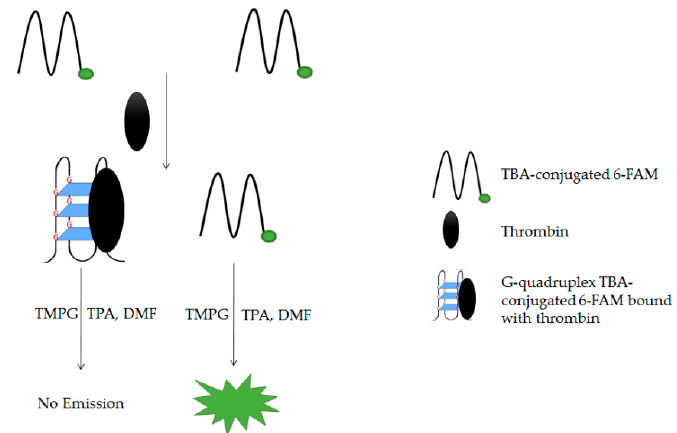
Figure 20. Schematic illustration of G-quadruplex-TBA aptasensor with guanine chemiluminescence detection principle.